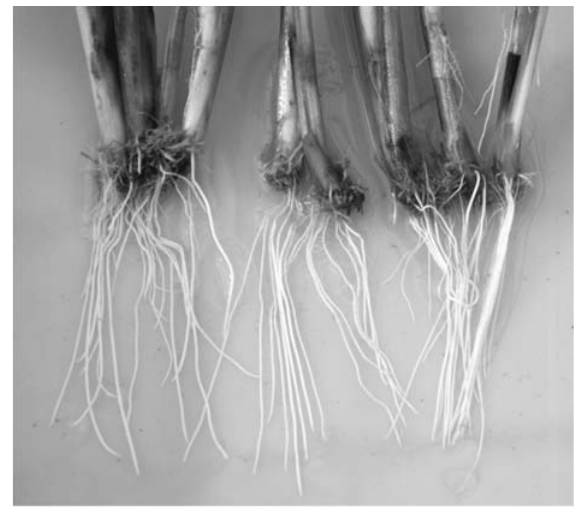
Figura 2. Plantas de arroz retiradas do saco de vinil que foi mantido enterrado no solo alagado.